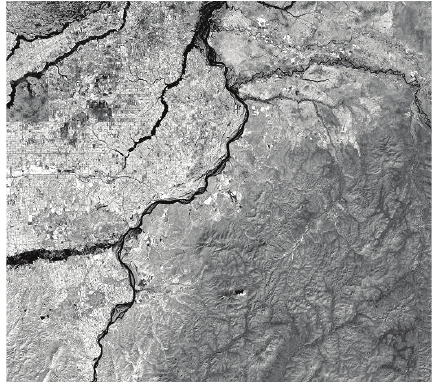
Figure 3: Test remote sensing